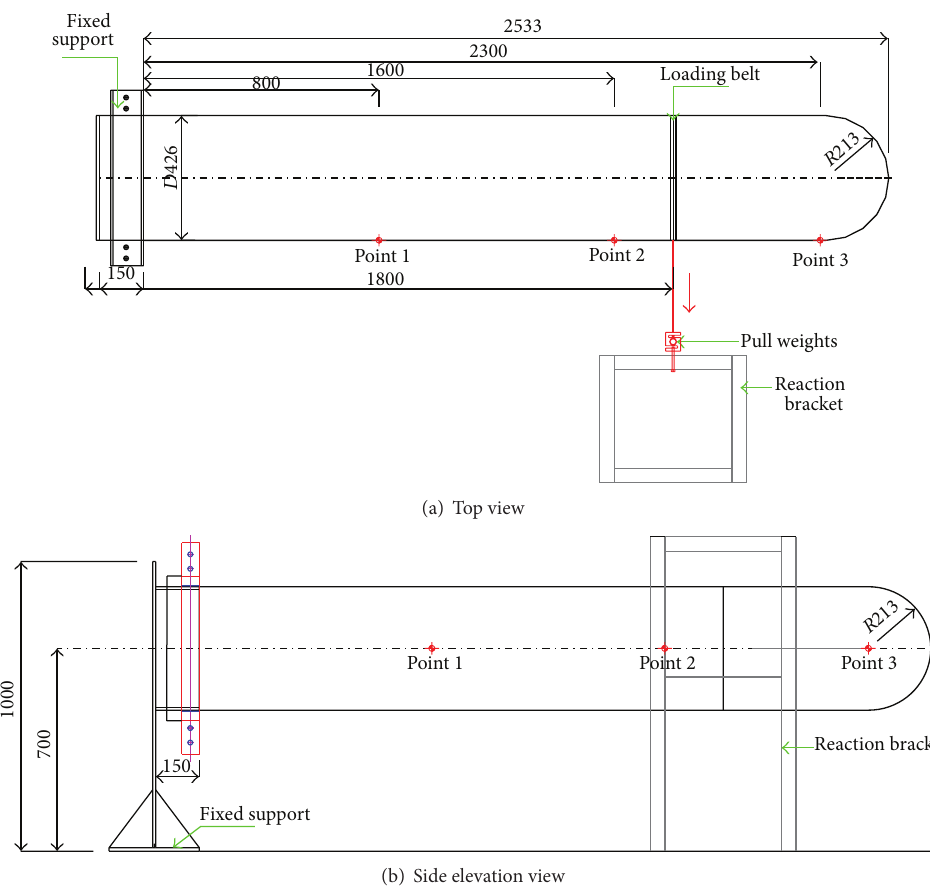
Figure 1: Layout of measuring points and test rig.